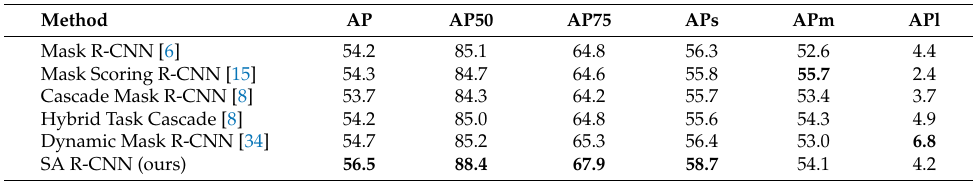
Table 2. Segmentation performance comparison between different instance segmentation methods on HRSID.